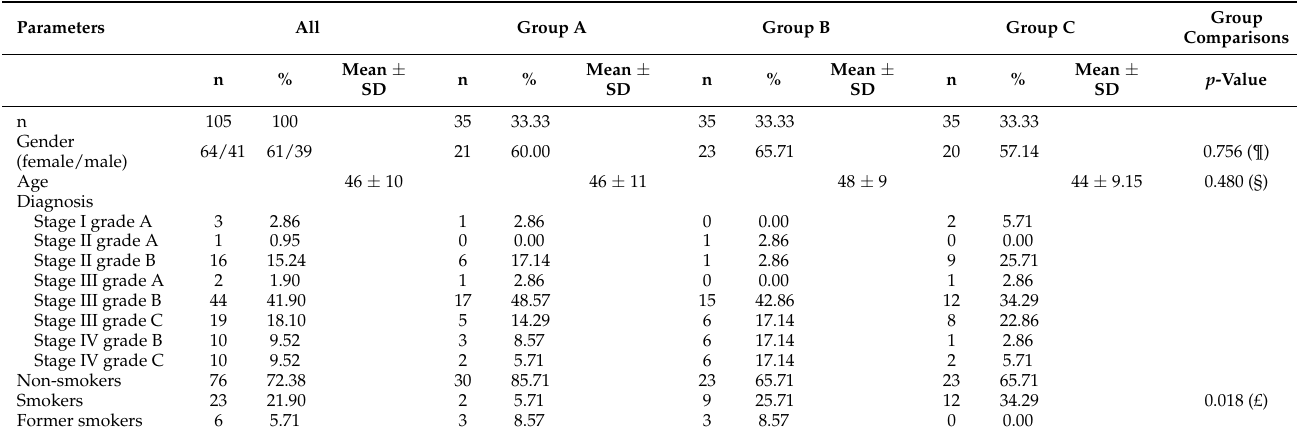
Table 1. Demographics at baseline of n = 105 patients randomized into three groups (A: PDT, B: LDDs, C: control) of n = 35 patients each.